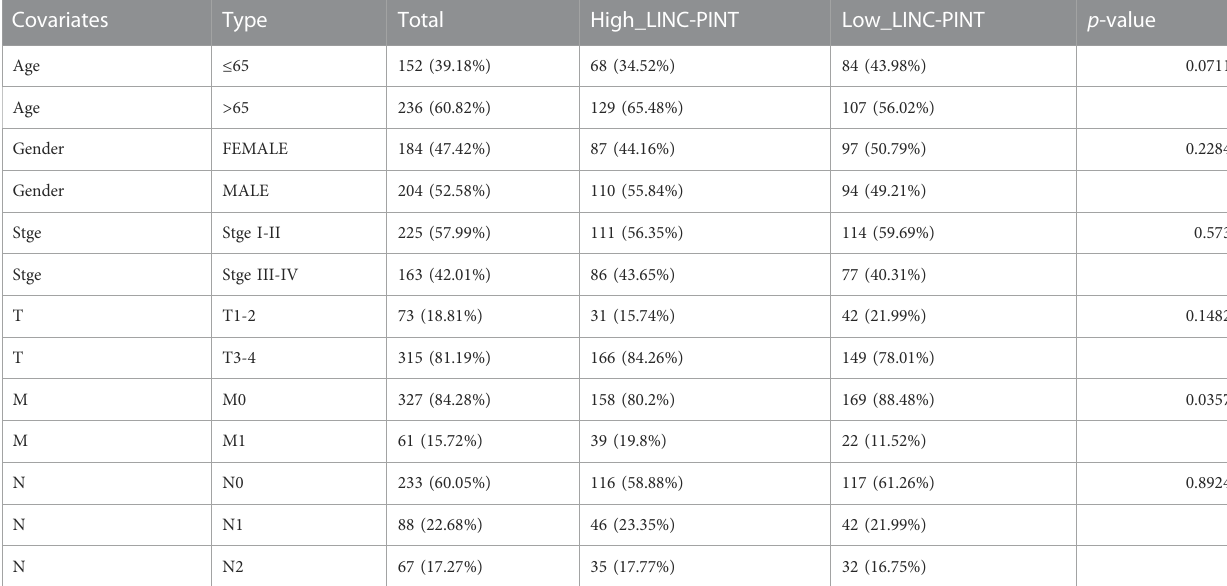
TABLE1ClinicalfeaturesoftheLINC-PINTinCOAD.Outofthetotalof473COADsamples,we fi lteredoutthecompleteclinicalinformationof388casesfromTCGA, and based on the LINC-PINT expression, the patients were divided into high and low-expression groups. Furthermore, patients were categorized based on their clinical characteristics (age, gender, T, N, M, stage, etc.) and compared the distribution of LINC-PINT high and low-expression samples in different groups. The proportion of M0 and M1 in the high-expression group was 80.2% and 19.8%, whereas in the low-expression group M0 and M1 proportion was observed as 88.48% and 11.52%, respectively. The distributions of metastasis-related clinical features were also signi fi cantly different than the control.